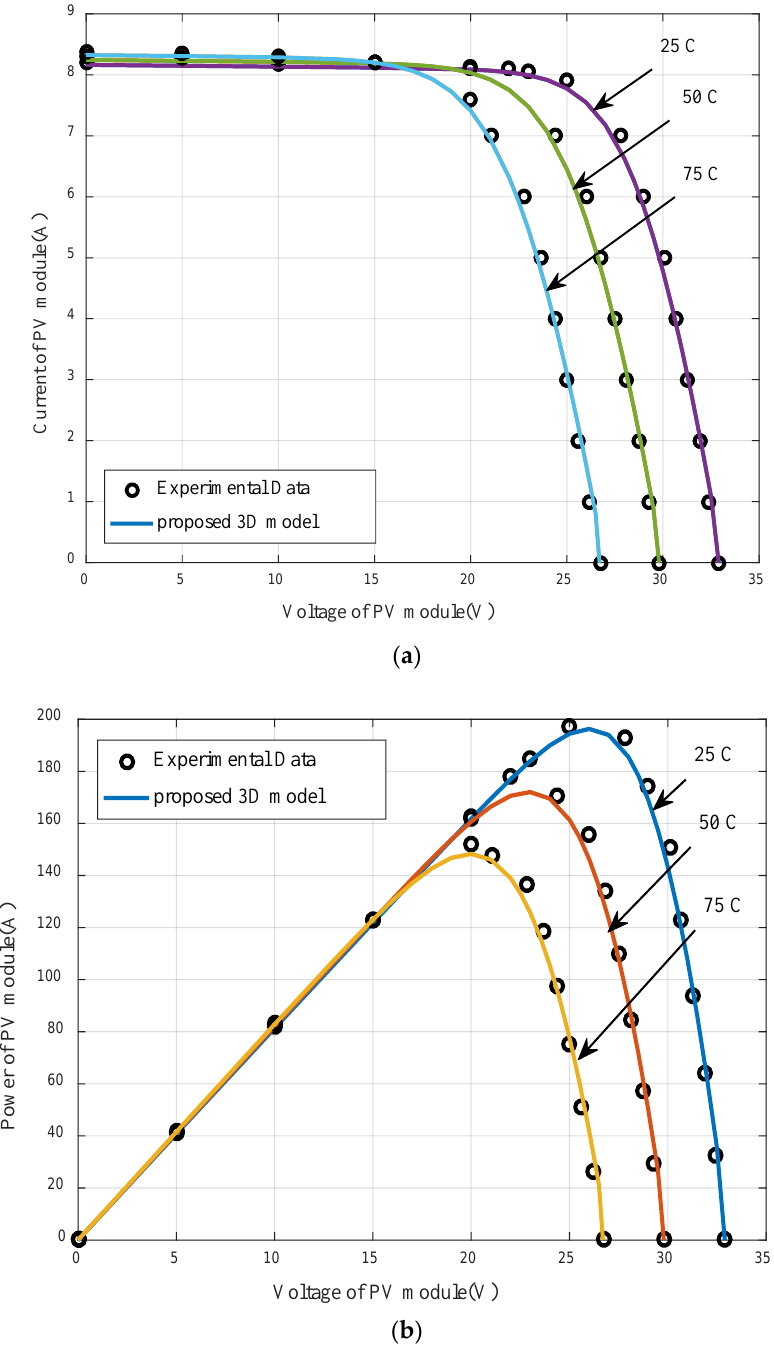
Figure 4. GOA-based simulation results and practical data of KC200GT module at various temperature conditions, G = 1000 W / m 2 . ( a ) I-V curves; ( b ) P-V curves.